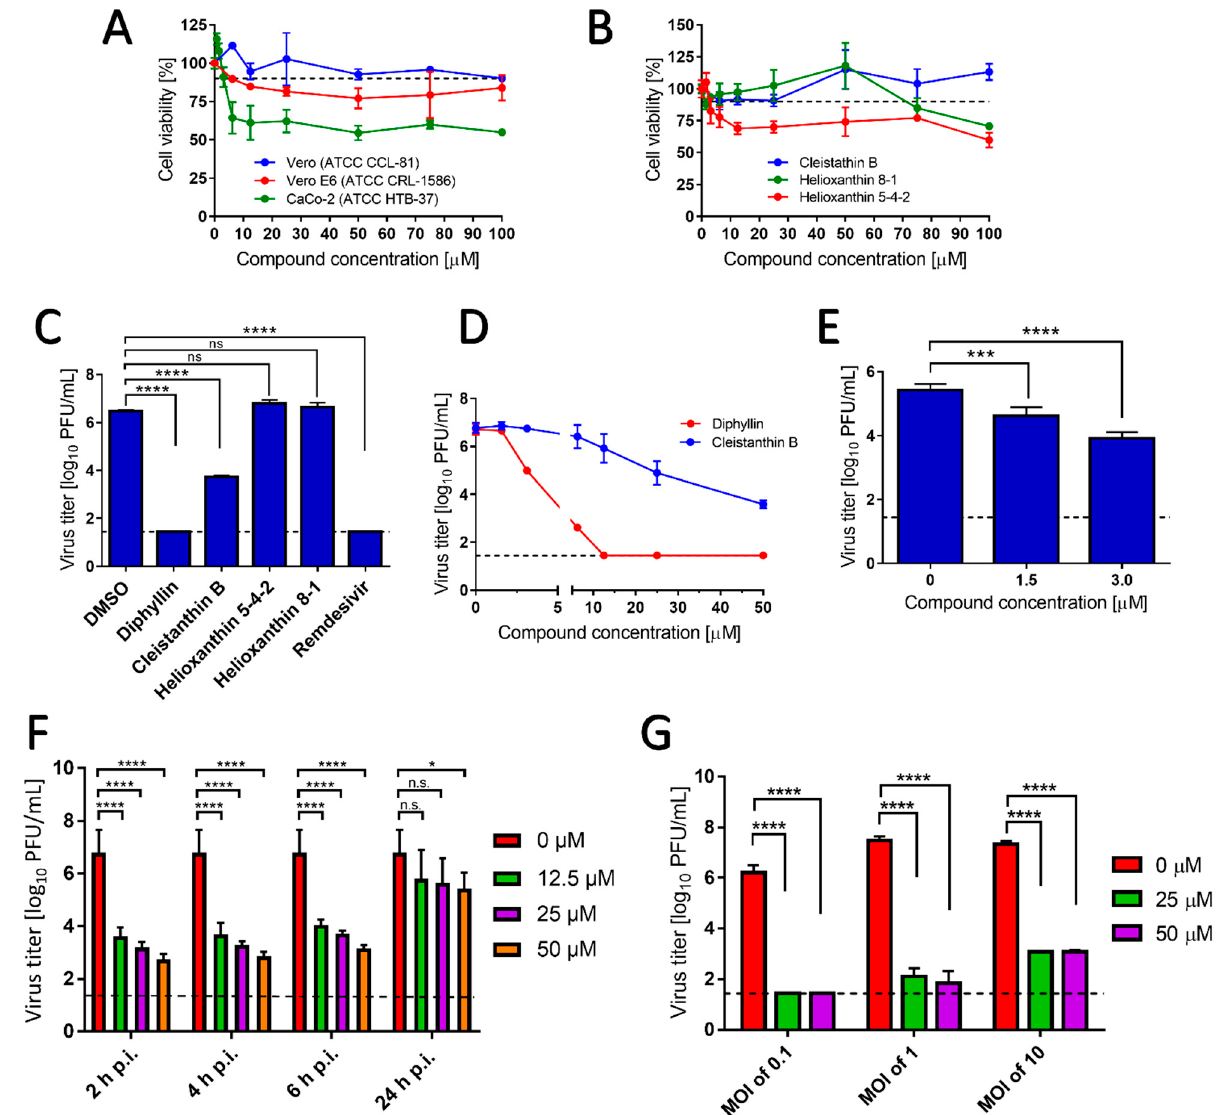
Figure 2. ( A ) Cytotoxicities of diphyllin in Vero, Vero E6, and CaCo-2 cells are shown and expressed as percentage of cell viability. The cells were treated with diphyllin at the indicated concentrations and incubated for 48 h. ( B ) Cytotoxicities of cleistanthin B, helixanthin 8-1, and helioxanthin 5-4-2 in Vero cells are shown. The cells were treated with the compounds at the indicated concentrations and incubated for 48 h. ( C ) Anti-SARS-CoV-2 activities of diphyllin, cleistanthin B, helixanthin 8-1, and helioxanthin 5-4-2 are shown as measured in Vero cells infected with SARS-CoV-2 (multiplicity of infection (MOI) of 0.1) and simultaneously treated with each compound under investigation (50 µ M). Infected cells were incubated separately with each compound under investigation for 48 h post infection (h.p.i.) and viral titers were determined using the plaque assay. Remdesivir was used as a positive control. ( D ) Growth curves are shown of SARS-CoV-2 in Vero cells treated with diphyllin and cleistanthin B (at the indicated concentrations). Vero cells were infected with the virus (MOI of 0.1) and simultaneously treated with the compounds under investigation, then incubated for 48 h.p.i. Viral titers were quantified using the plaque assay. ( E ) Anti-SARS-CoV-2 activities are shown in CaCo-2 cells using diphyllin at the indicated concentrations. ( F ) Anti-SARS-CoV-2 activities are shown in SARS-CoV-2-infected Vero cells that were treated with diphyllin 2, 4, 6, and 24 h.p.i. (at the indicated concentrations) then incubated up to 48 h. ( G ) Anti-SARS-CoV-2 activities are shown in SARS-CoV-2-infected Vero cells (MOIs of 0.1, 1, and 10) that were treated with diphyllin (at the indicated concentrations) and then incubated for 48 h.p.i. Viral titers were determined by a plaque assay. The mean titers from three biological replicates are shown, and error bars indicate standard errors of the mean. The horizontal dashed line indicates the minimum detectable threshold of 1.44 log 10 plaque forming units (PFU)/mL. n.s., not significant; *, p < 0.05; ***, p < 0.001; ****, p <